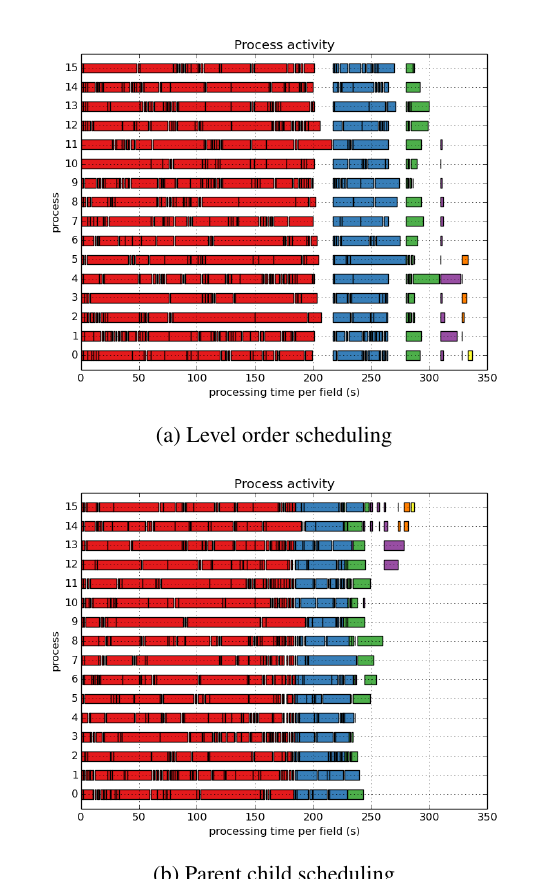
Figure 7: Two different scheduling orders for the cadastral dataset. Every rectangle represents one field. Note that different colours correspond to the levels of the fieldtree (i.e. red corre- sponds to the fields with finest grid size). (a) Level order schedul- ing. The process waits until all fields of the same level are pro- cessed before processing of the next level starts. (b) The parent child scheduling. Fields are scheduled for processing when all its upto 9 child fields are